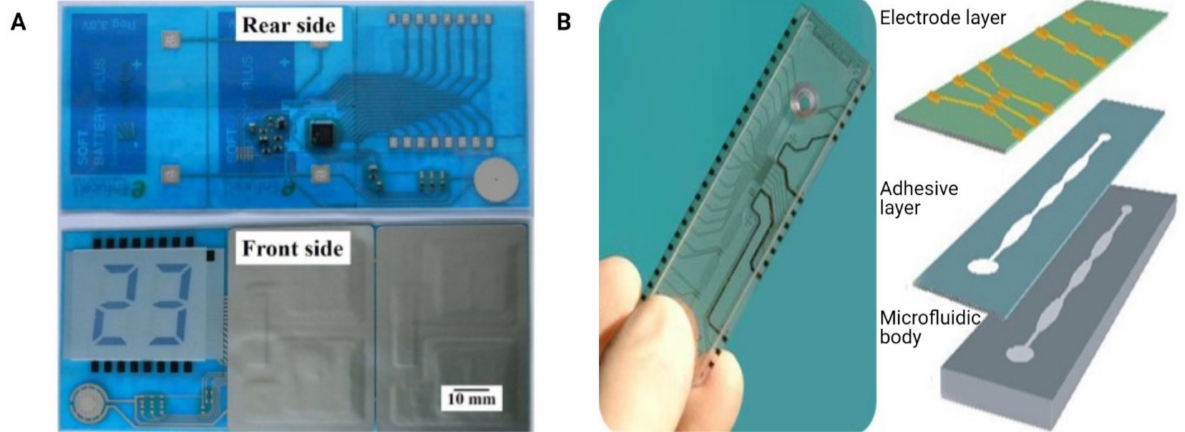
Figure 7. ( A ) Hybrid integrated temperature sensor label from [224] under creative commons 3.0. ( B ) Impedimetric point-of-care diagnostic cartridge described in [222] with electrode layer joined to microfluidic body using adhesive layer.